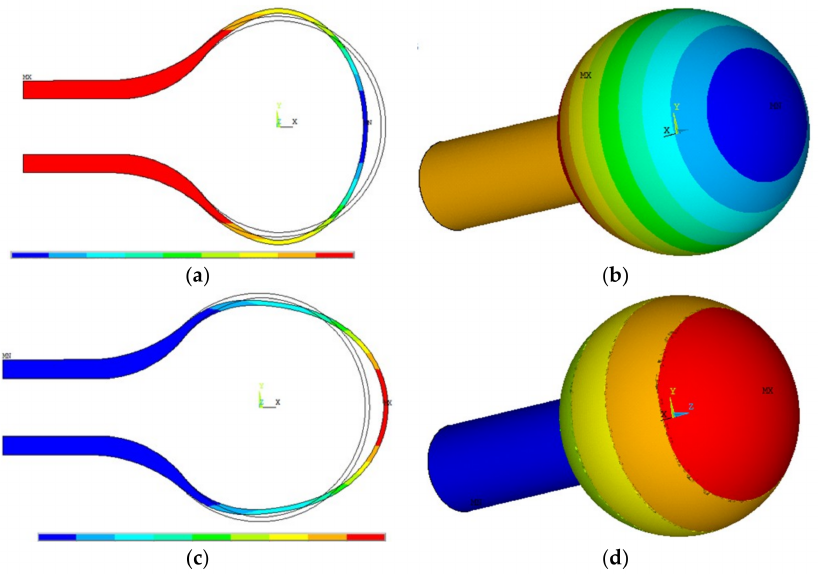
Figure 11. Deformation characteristic of the single-ended microbubble under the filling pressure of 4 and 1400 kPa. ( a ) Inner pressure: 4 kPa, 2D view; ( b ) inner pressure: 4 kPa, 3D view; ( c ) inner pressure: 1400 kPa, 2D view; ( d ) inner pressure: 1400 kPa, 3D